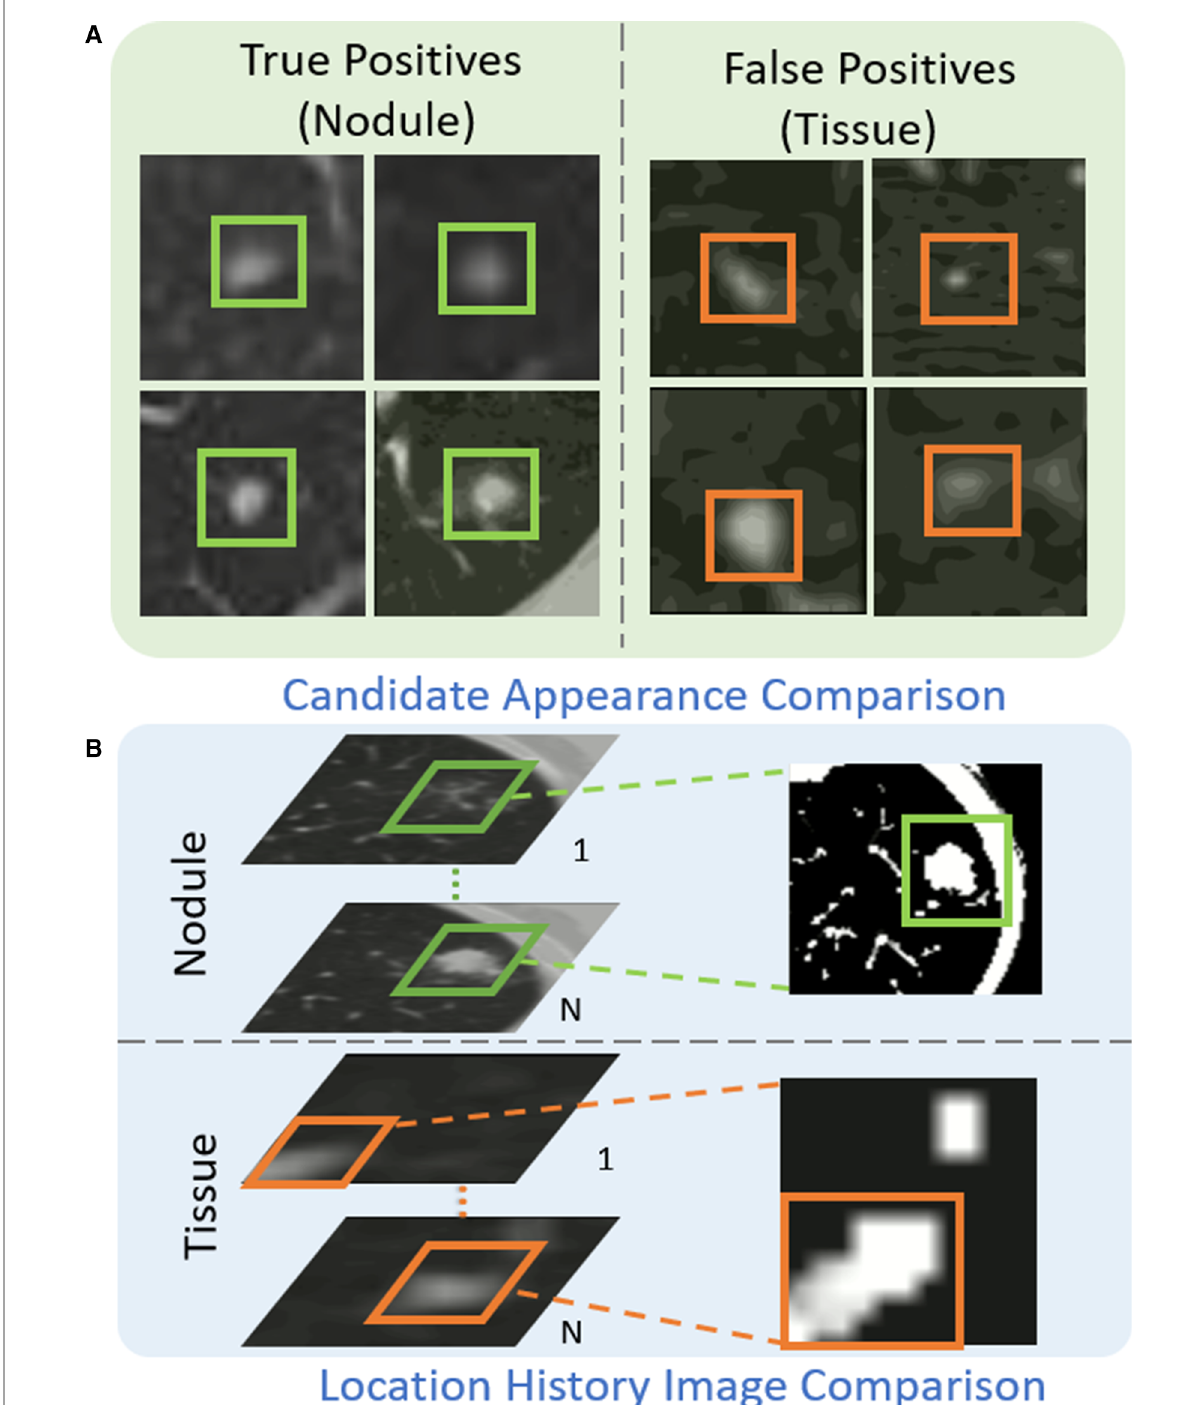
FIGURE 4 The proposed Location History Images (LHI) to distinguish tissues and nodules from the predicted nodule candidates. ( A ) The true nodules (green boxes) have similar appearances to the false detected tissues (orange boxes). ( B ) The location variances for nodules and tissues are oriented differently in LHIs. True nodules generally have a circular region representing the spatial changes as the brighter center (the size of the nodules decreases in the following CT slides) or a darker center (the size of the nodules increases in the following CT slides). On the other hand, the location variance for false detected tissues tends to change in certain directions, such as a gradual change of the trajectory